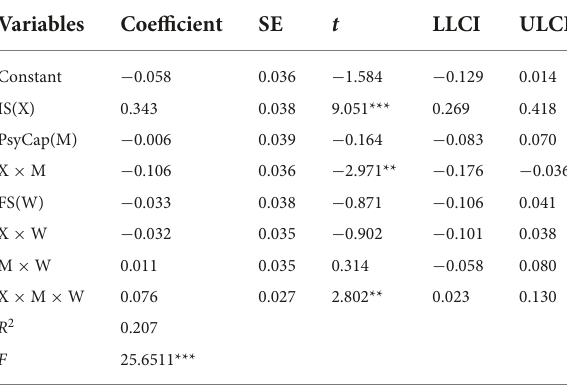
TABLE 3 Model characteristics for moderated moderation analysis (Y =